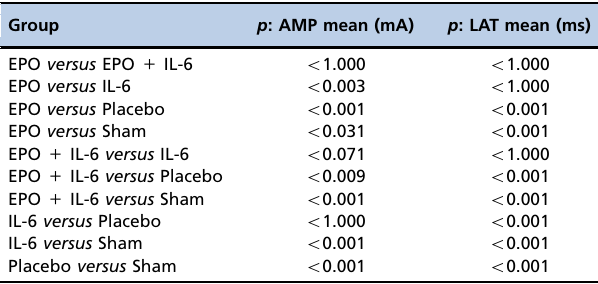
Table 3 - Comparison of mean latency (LAT) and mean amplitude (AMP) in the motor-evoked potential (MEP) exam: p -values. Group